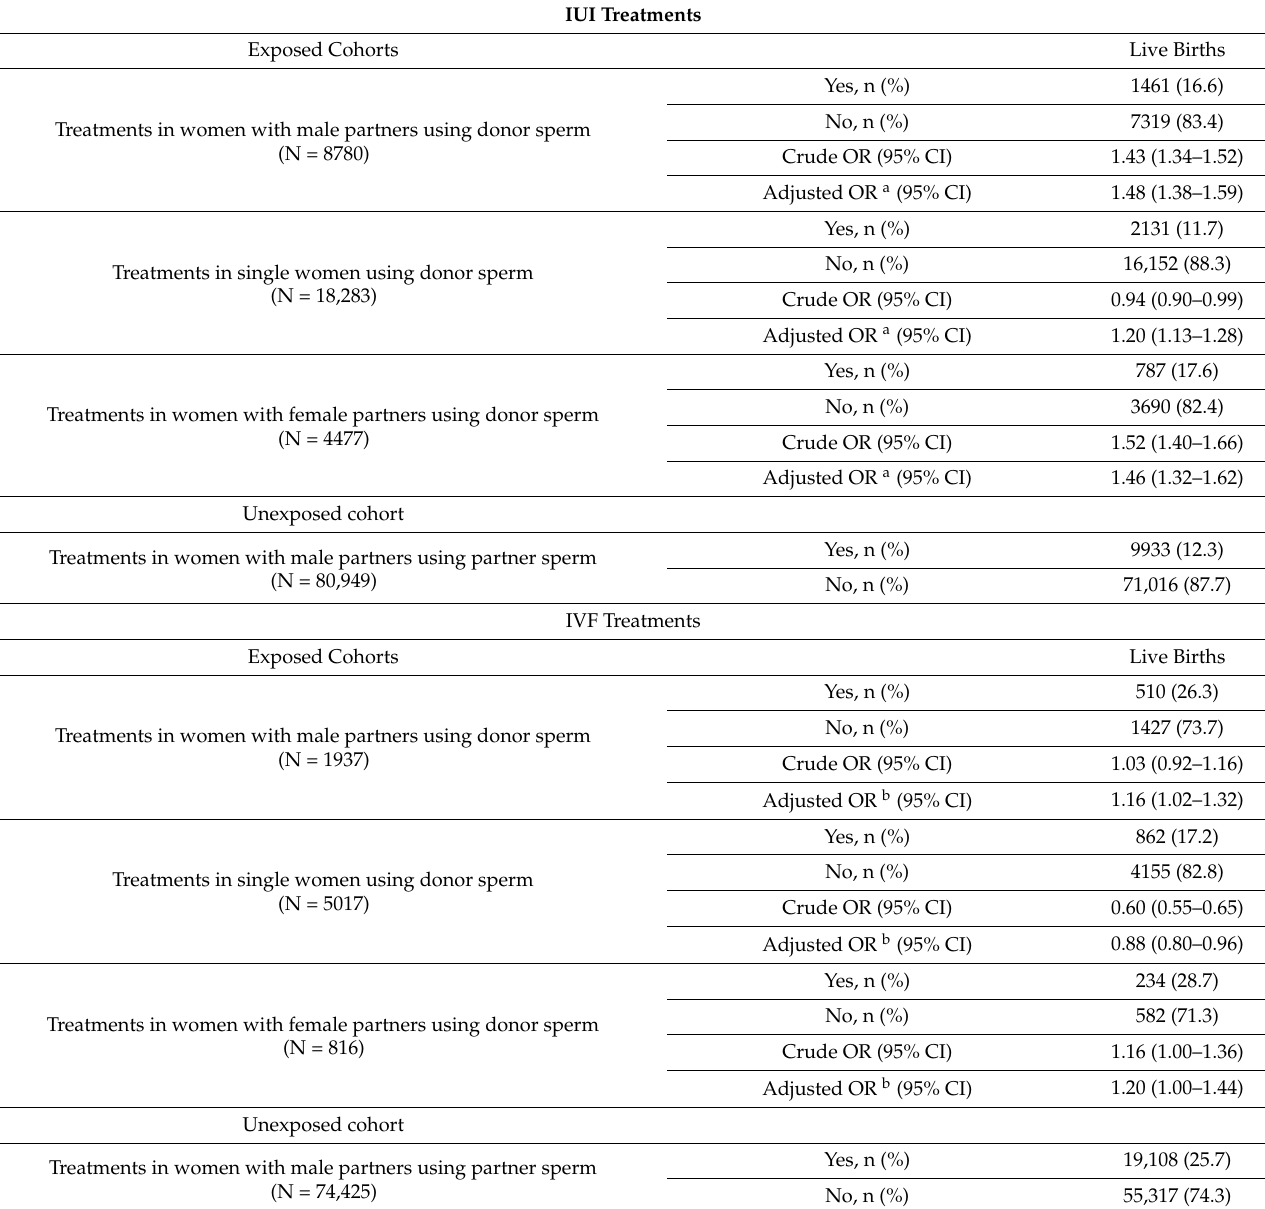
Table 2. Crude and adjusted odds ratios (ORs) for live births in women with male partners using donor sperm, single women using donor sperm, women with female partners using donor sperm, and women with male partners using partner sperm in IUI and IVF